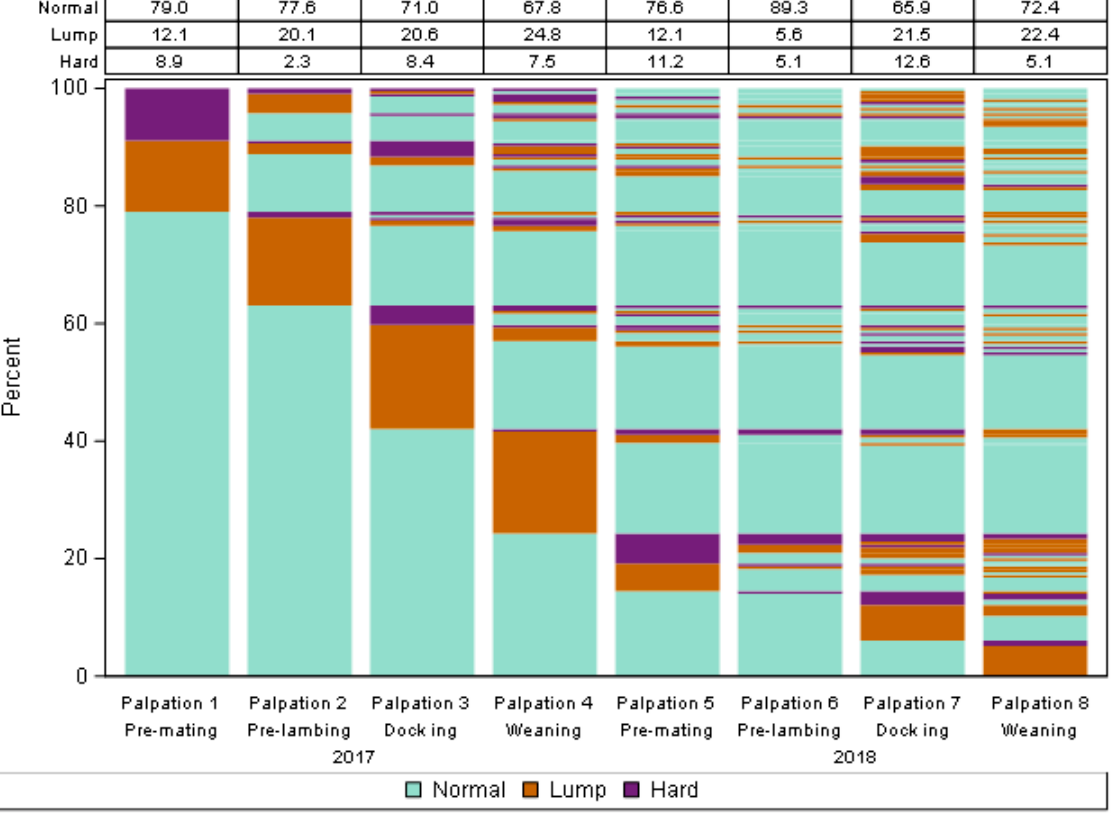
Figure A3. Lasagna plot of palpable udder half defects (hard, lump, and normal) from non-dairy Romney ewes identified during udder examination events occurring at key management times (pre-mating, pre-lambing, docking, and weaning; Study A). Lasagna plot of 214 udder halves in the years 2017 and 2018, excluding udder halves observed with no udder defect on all occasions. Note: Within each plot, each bar shows a different udder half scoring event (i.e., time) while the different colours within each bar represent the defect categories. The data in the table at the top of each plot designates the percentage (%) of each udder half defect category at each event, which corresponds to the percentage of each colour at each event. Change in defect category over time of each udder half can be tracked by following longitudinal transitions across the udder scoring events of stacked bars.